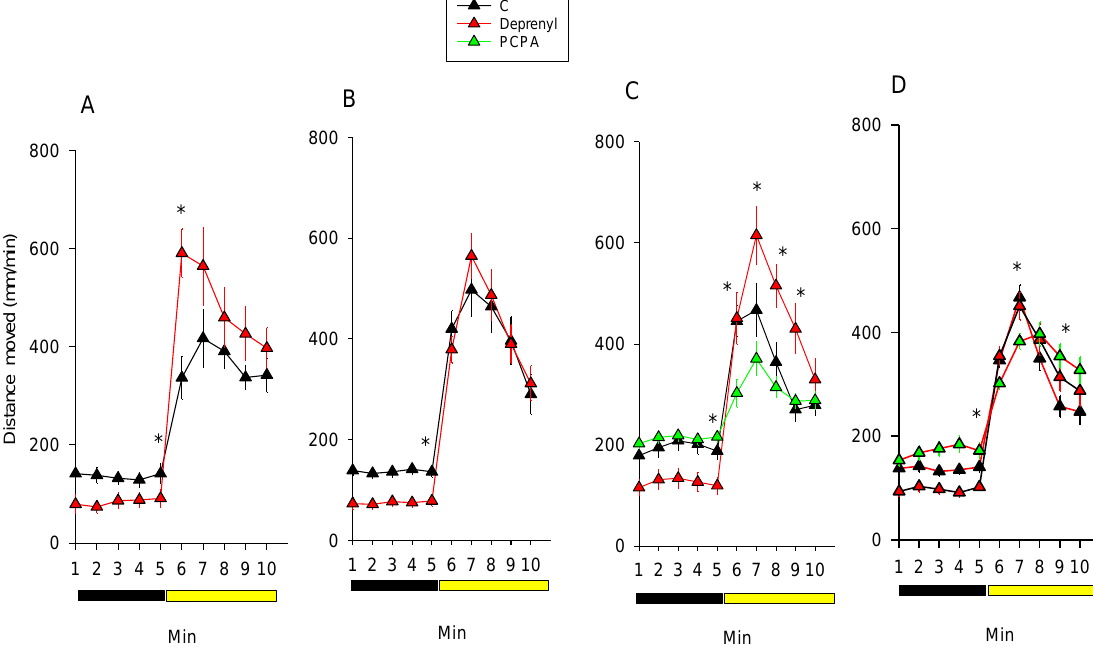
Figure 2. Daphnia basal locomotor activity (BLM) and visual motor responses (VMR) across 5 min in darkness and 5 min with light following 24 h exposures to 1 and 10 mg/L of deprenyl and PCPA, respectively. Plots of the average distance moved ± SE ( n = 12–24) per minute across the 10 min of the monitored period are shown. Graphs ( A , B ) depict the data obtained across two independent experiments for deprenyl exposures and ( C , D ) for deprenyl and PCPA ones. Note: * during the minutes 5–10, mean significant ( p < 0.05) treatment differences relative to the controls following the Student’s t -test or ANOVA and Dunnett’s test.